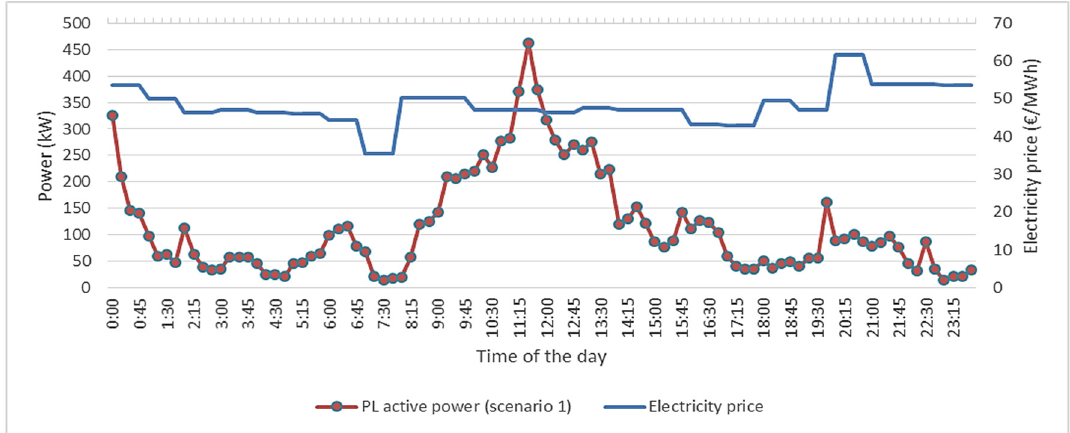
Figure 8. PL’s active power in scenario 1 and electricity price.